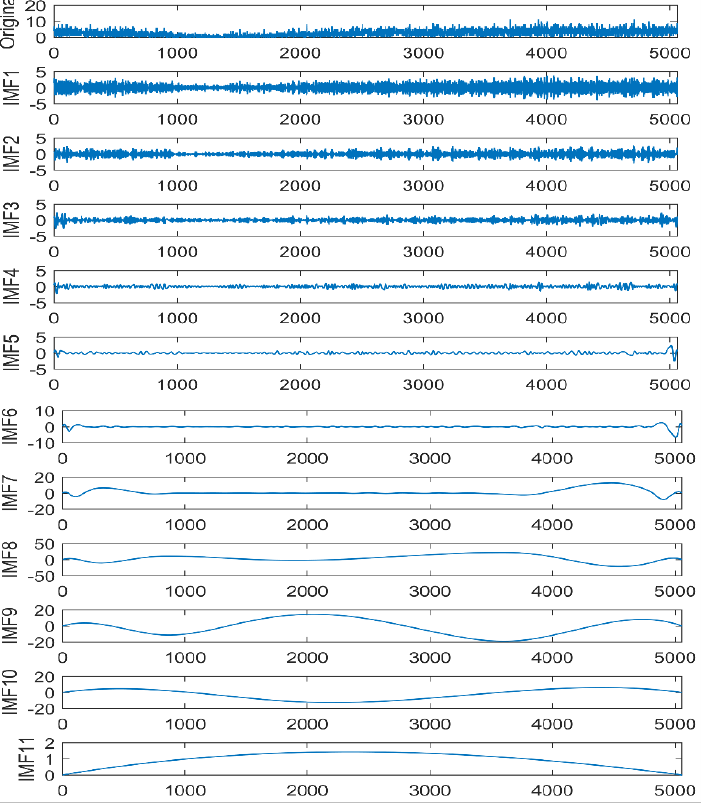
Figure 6. Decomposition effect of the EMD